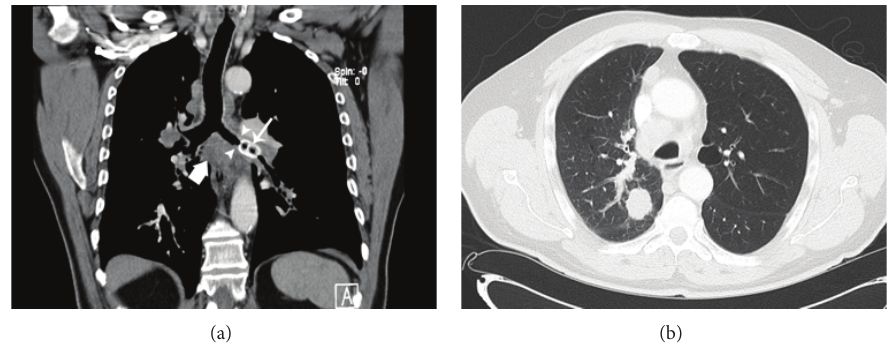
Figure 2: Reformatted coronal CT MIP image in soft tissue window-level setting (a) demonstrates presence of a hyperdense foreign body (solid arrow) within a thickened left mainstem bronchus (arrowheads). Also noted is subcarinal (block arrow) and hilar adenopathy which was later shown to represent nodal metastasis from lung adenocarcinoma. Axial CT imaging in lung window-level setting (b) shows resultant hyperinflation and hyperlucency of the left upper lobe related to